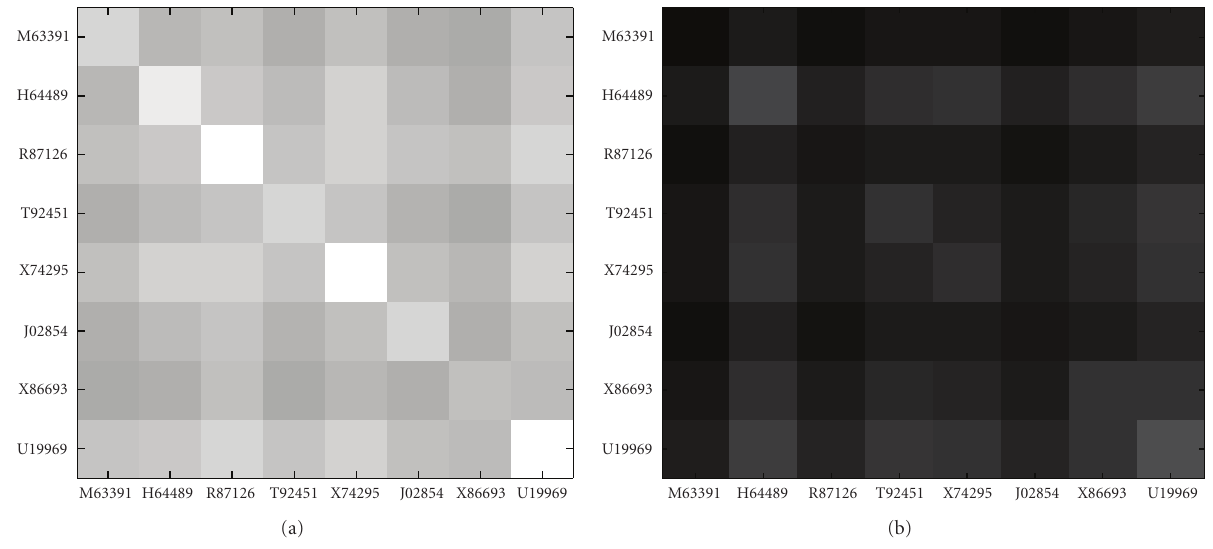
Figure 5: Images of the MI matrices for the eight genes in colon dataset. (a) Normal samples. (b) Disease samples.